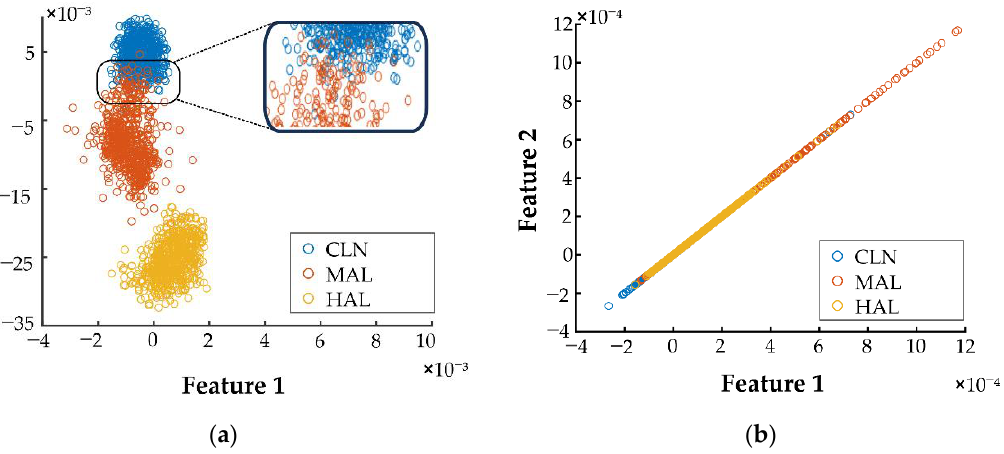
Figure 7. LDA projection obtained ( a ) using the optimized feature set and ( b ) using the complete feature set. Table 5. Confusion matrix for the estimation of dust level using the optimized feature set. Assigned Class